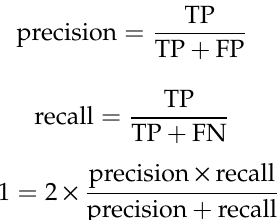
Figure 14. Small target detection results of CFF-SDN model on DSDR dataset. ( a ) The pixels of the ship target in the image are less than 7 × 7; ( b ) The sizes of the two targets are 22 × 18 and 24 × 76 respectively; ( c ) The pixels of the ship target are smaller than 36 × 51; ( d ) The ship targets in the image are very small, the smallest is only 6 × 10. ( e – h ) are the detection results of small target ships in the images ( a – d ), and all small ships in ( e – h ) have been detected by our model. The CFF-SDN model can detect all small targets in the image.